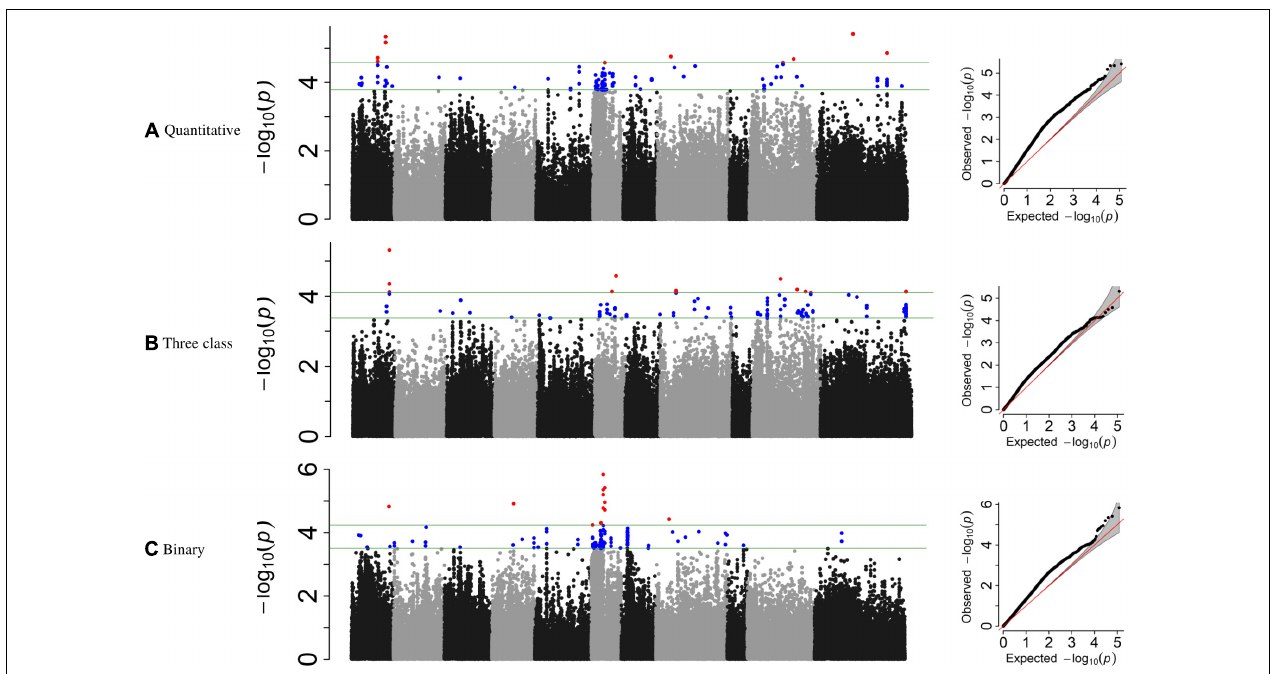
FIGURE 4 | Manhattan plots and corresponding QQ-plots from GWAS analysis of (A) quantitative, (B) three-class, and (C) binary scoring systems in MDP.